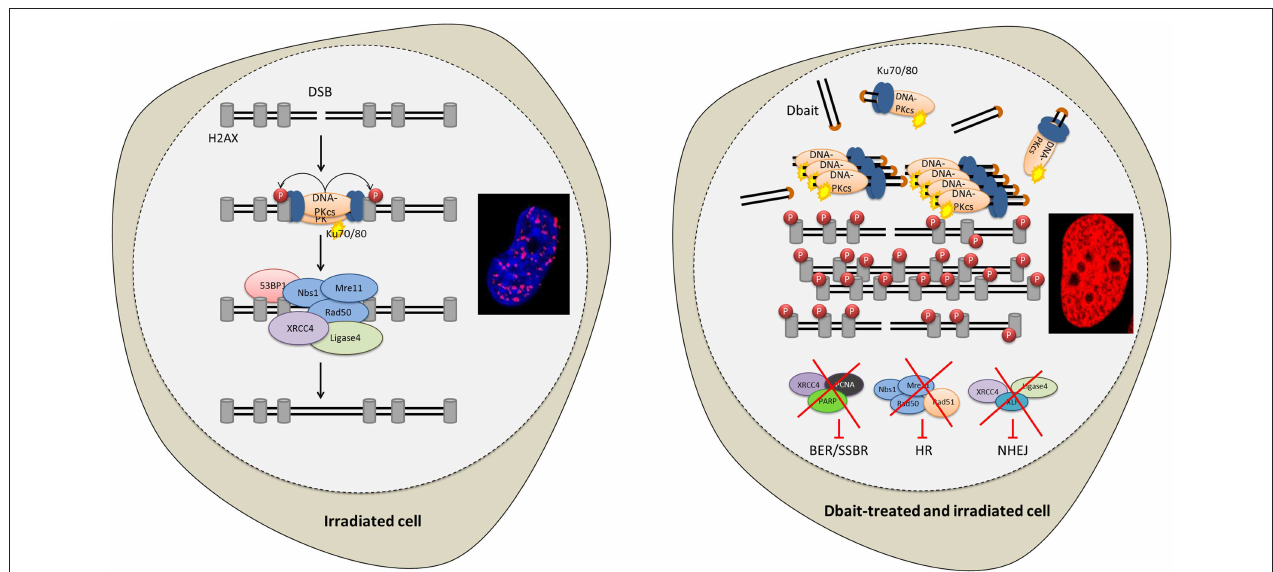
FIGURE 1 | Disrupting DNA repair with Dbait molecules. Radiation and Dbait treatment induce DNA repair signaling disturbance. Dbait recognize and activates DNA-PK complex leading to its activation and its subsequent nuclear targets phosphorylation visualized by pan-nuclear γ -H2AX. When a DSB occurs in the DNA, the DNA damage signaling system activated by Dbait is spread across modified chromatin and prevents the arrival of proteins involved in DSB repair at site of the damage. Consequently, both non-homologous end joining (NHEJ) and homologous recombination (HR) were inhibited. Moreover, Dbait can also recognize